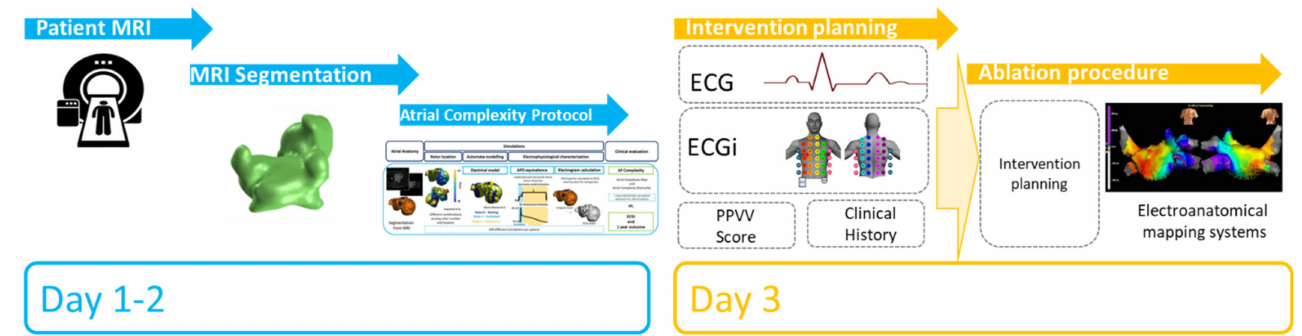
Figure 7. Protocol proposal for the integration of the method in a clinical environment.